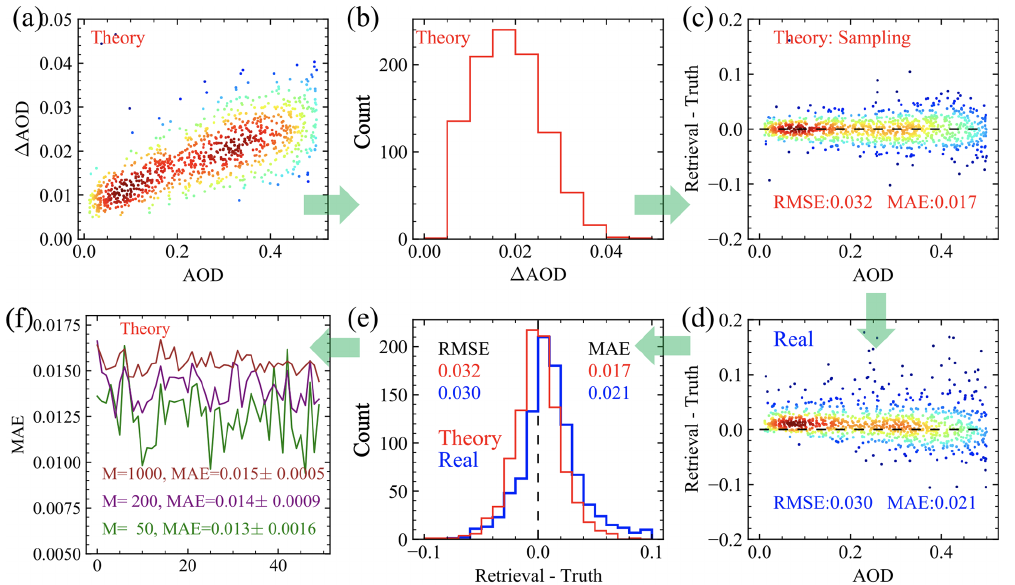
Figure 1. Demonstration of the procedures to compare theoretical and real uncertainties. (a) Theoretical uncertainties of AOD retrievals over 1000 synthetic HARP2 measurements; (b) histogram of panel (a) ; (c) the retrieval error sampled from panel (a) ; (d) the retrieval error derived from the difference between the real retrieval results and truth data; (e) the histogram for the retrieval errors in both panel (c) and (d) ; (f) the MAE for 50 sets of random theoretical errors considering a total number of cases of 50, 200, and